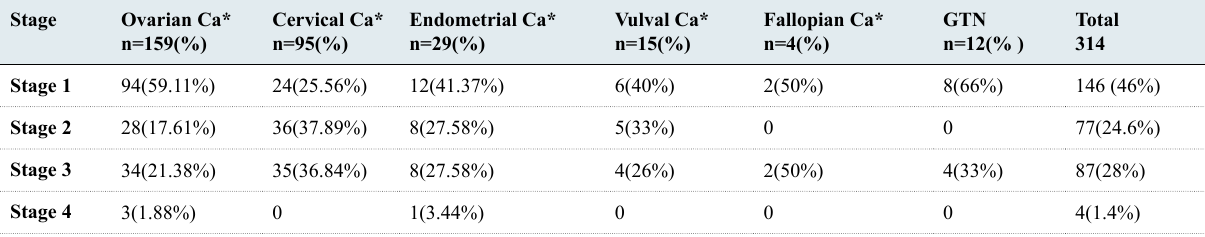
Table 5: Distribution of gynecological cancer according to the stage of diagnosis